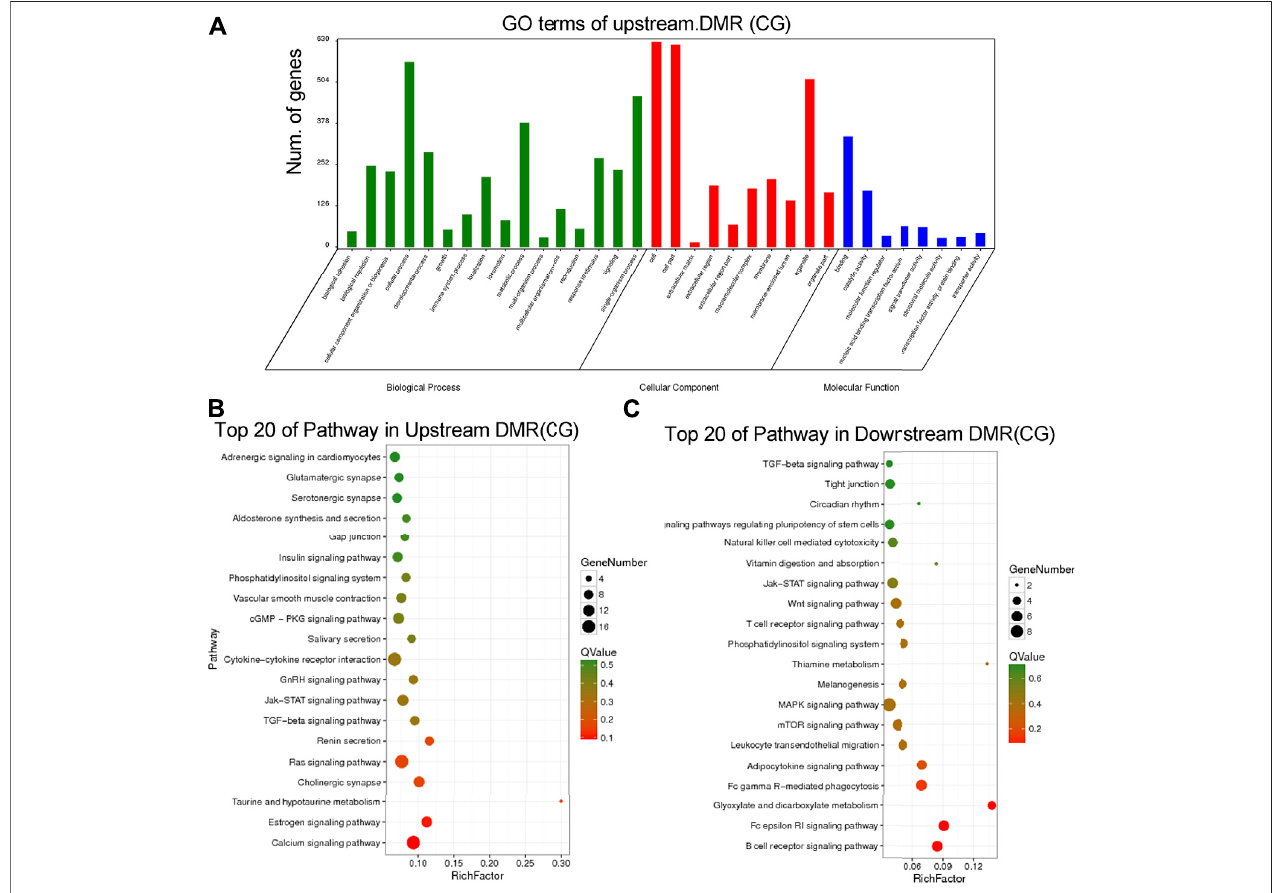
FIGURE 6 | Annotation of the differently methylated regions (DMRs) in chronic in fl ammation mice genomic. (A) Gene Ontology (GO) enrichment result showed the DMRs enriched in biological process, cellular component, and molecular function. (B) The top 20 Kyoto Encyclopedia of Genes and Genomes (KEGG) pathway of upstream DMR (CG)-related genes. (C) The top 20 KEGG pathway of downstream DMR (CG)-related genes.